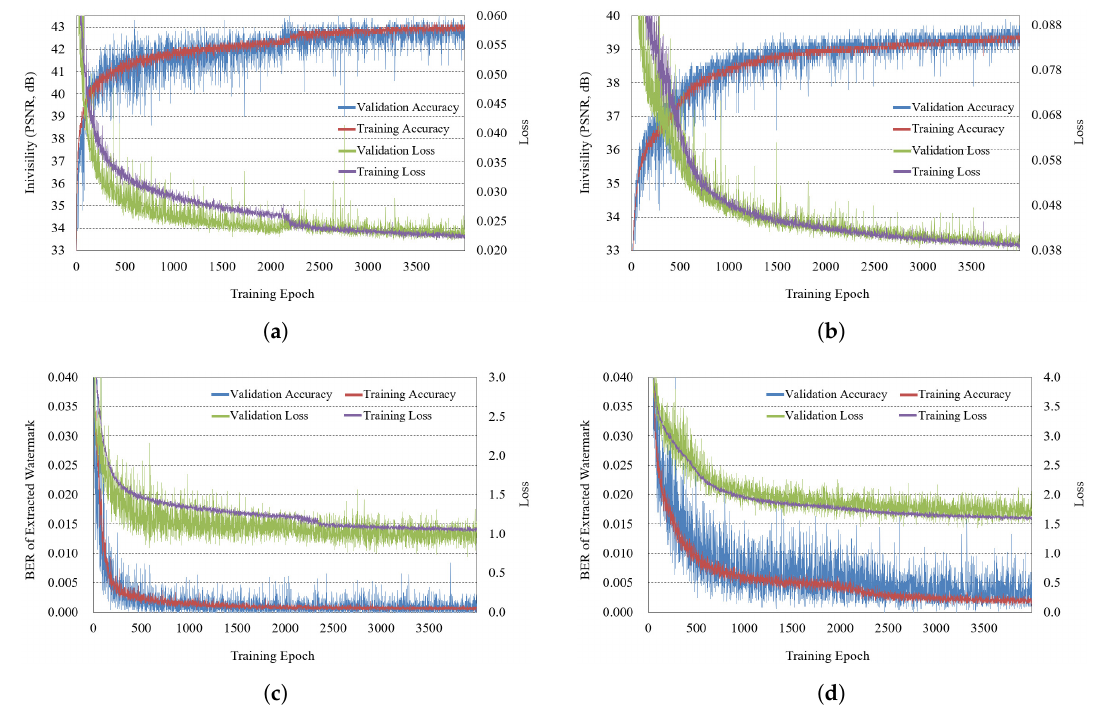
Figure 7. Training result without reconstruction ( a ) watermark embedding (real), ( b ) watermark embedding (amplitude), ( c ) extracting (real), ( d ) extracting (amplitude).